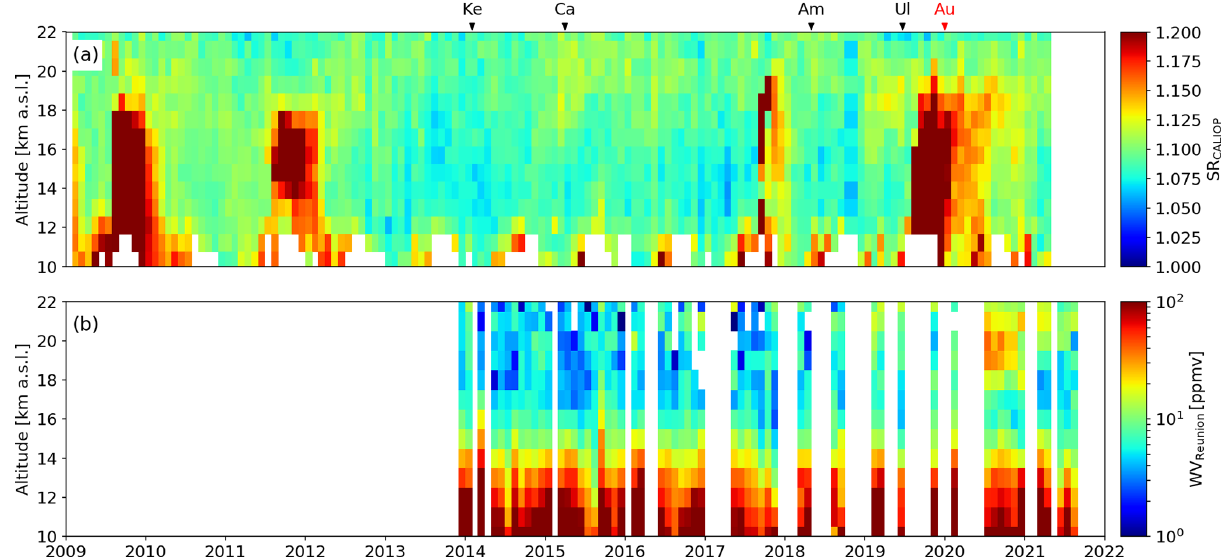
Figure 3. (a) Monthly and zonally averaged time series of aerosol scattering ratio derived from CALIOP between 2009 and the end of 2021 at 25–20 ◦ S (Reunion Island). Major eruptions (black triangles) and PyroCb events (red triangle) are indicated at the top of the plot (see Table 1). (b) Monthly averaged Lidar1200 water vapor mixing